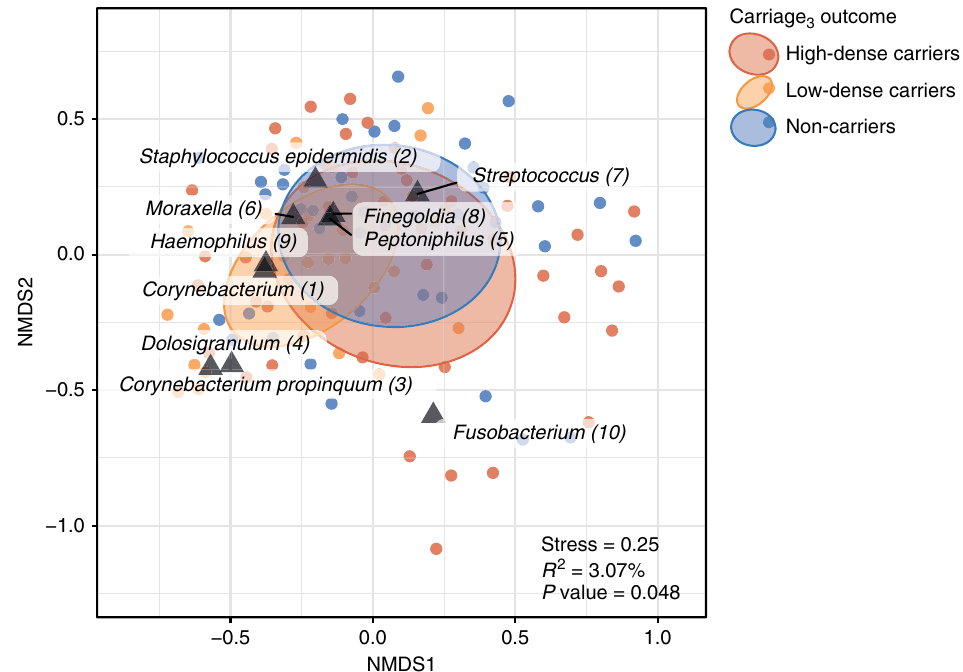
Fig. 2 Baseline nasal microbiota composition in association with pneumococcal carriage 3 outcome. Non-metric multidimensional scaling (NMDS) plot where each point represents the microbial community composition of one sample. Samples ( n = 116) were coloured according to carriage 3 outcome (red, high-dense carriers, n = 49; blue, non-carriers, n = 40 and orange, low-dense carriers, n = 27). The standard deviation of data points within carriage outcome groups is shown. In addition, the 10 highest ranked operational taxonomic units (OTUs) were simultaneously visualized (triangles). The stress value indicates how well the high-dimensional data are represented in the two-dimensional space; a value of ~0.2 indicates a reasonable representation. P values and effect sizes ( R 2 ) describing the strength and the signi fi cance of the association between baseline nasal microbiota and pneumococcal carriage outcome were generated using PERMANOVA tests, and are adjusted for the month, presence of any virus at baseline, the interactions between carriage outcome and the vaccination group/presence of any virus at baseline. See Table 1 for details